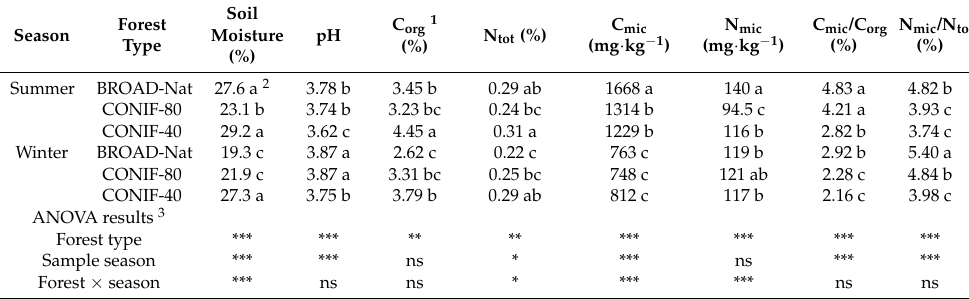
Table 2. Soil chemical and physical properties and microbial biomass in 40-year-old (CONIF-40) and 80-year-old (CONIF-80) coniferous plantations and a natural broadleaf forest (BROAD-Nat) in two seasons.